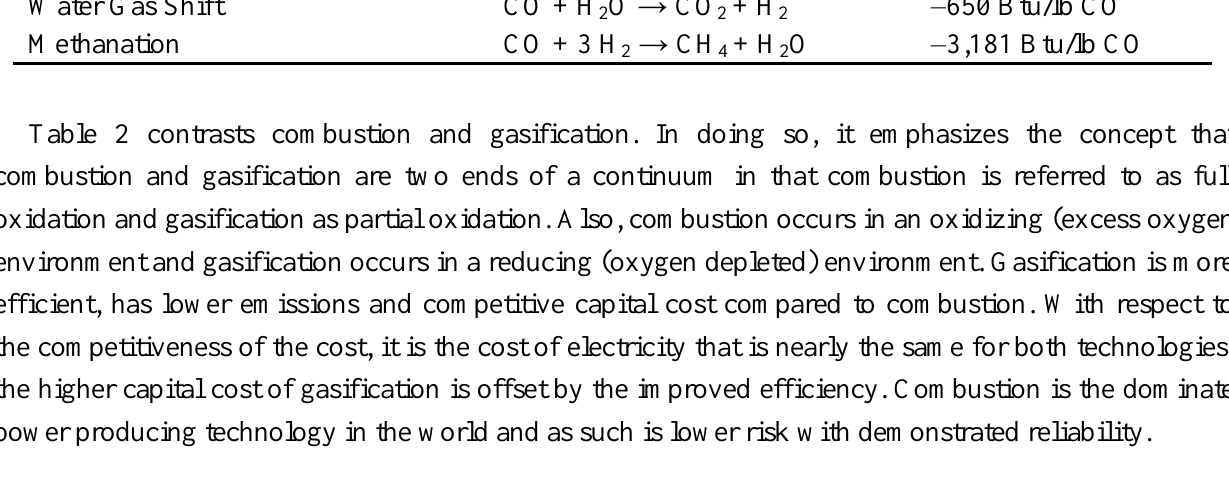
Table 2. Contrasts between Combustion & Gasification